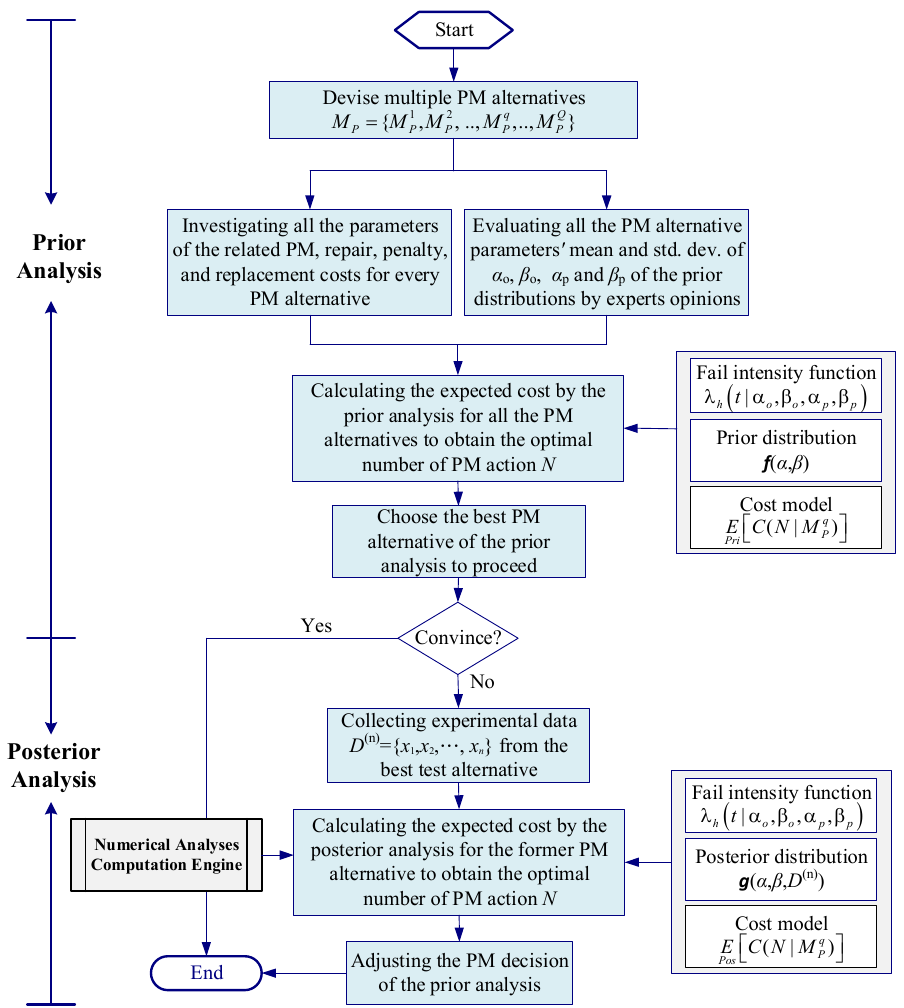
Figure 4. Flowchart for Bayesian decision process.